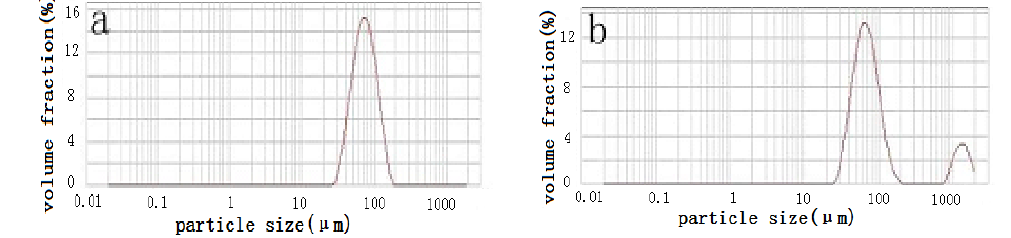
Figure 3. Particle size distribution of ( a ) NiCrMoY powders and ( b ) Ni60A powders.